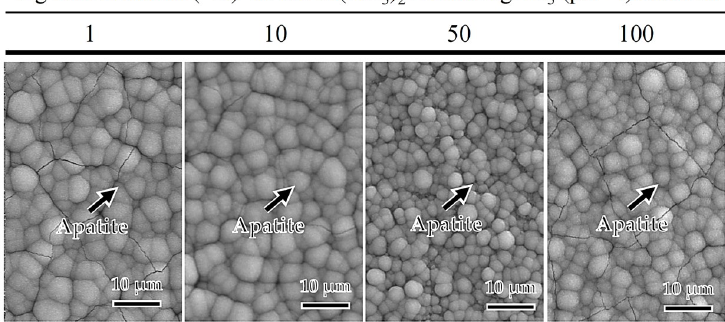
Figure 6. XRD ( a ) and Raman ( b ) spectra of Ti surfaces subjected to Sr + X mM Ag (pH = 4) treatment with various Ag concentrations ( X = 1–100) following NaOH, Ca + Sr and heat treatment.